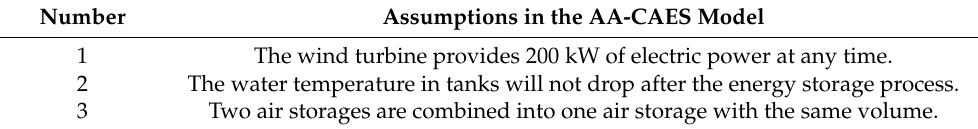
Table 4. AA-CAES model